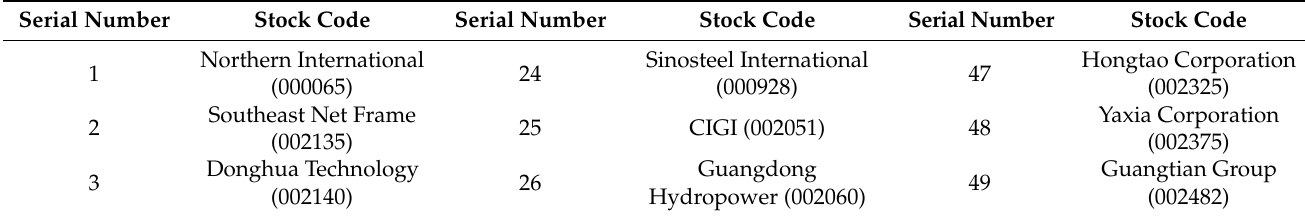
Table 3. Sample company information